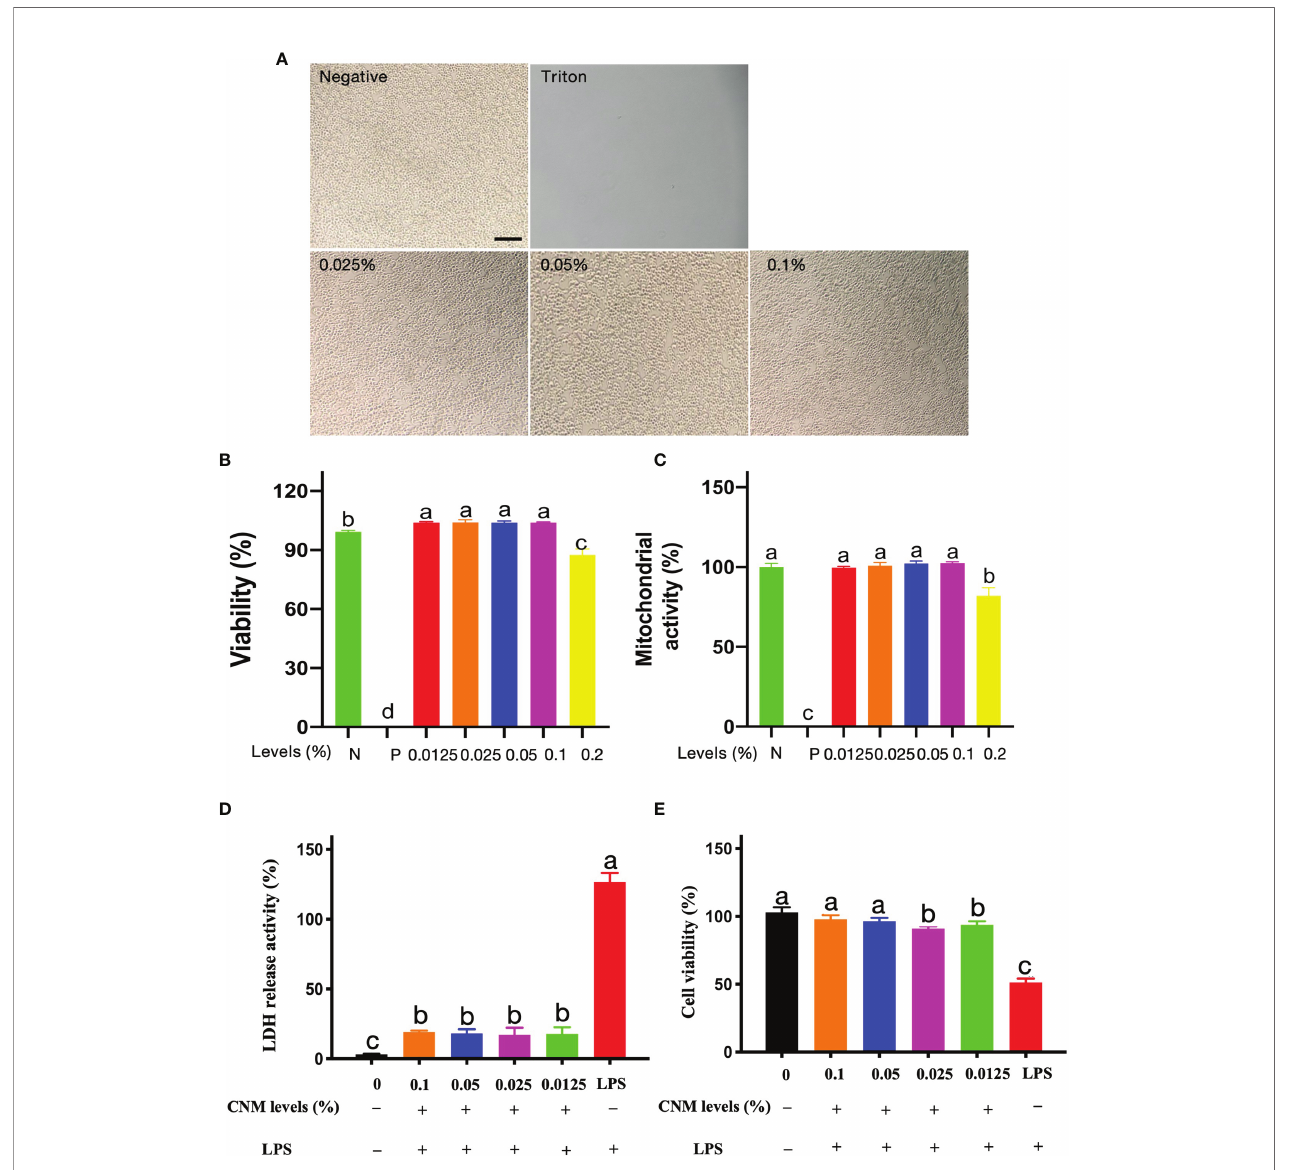
FIGURE 4 | Cytoxicity risk assessment of CNMs at various concentrations. (A) Cell morphology was observed after treatment with CNMs. Mouse RAW264.7 cell morphology after treatment with 0%, 0.025%, 0.05%, and 0.1% CNMs for 24 h. Triton X-100 was used as a positive control. Morphology change of cells was measured. The scale bar indicates 200 µm. Data are presented from two independent experiments. (B, C) The cytotoxic activity of CNMs toward RAW264.7 cells. Cells were treated with various concentrations of CNMs for 24 h, then cell viability was determined by LDH assay (B) ; mitochondrial activity was measured by MTT assay (C) . Positive control was Triton X-100. Data shown as the mean ± standard error of three independent experiments. Means with different lowercase letters indicate signi fi cance ( p < 0.05). N: negative control; P: positive control. (D, E) CNMs inhibited LPS-induced cytotoxicity to RAW264.7 cells. CNMs at different concentrations were added to the medium and cultured for 24 h, then 1 µg/ml LPS was applied to treat cells and cultured for 8 h. LDH and MTT assays were applied to evaluate the anti-LPS-induced cytotoxicity of CNMs. LDH release assay (D) and MTT assay (E) of RAW264.7 cells treated with CNMs at various concentrations. Data are indicated as the mean ± standard error from six biological replicates. Means with different lowercase letters indicate signi fi cance ( p <